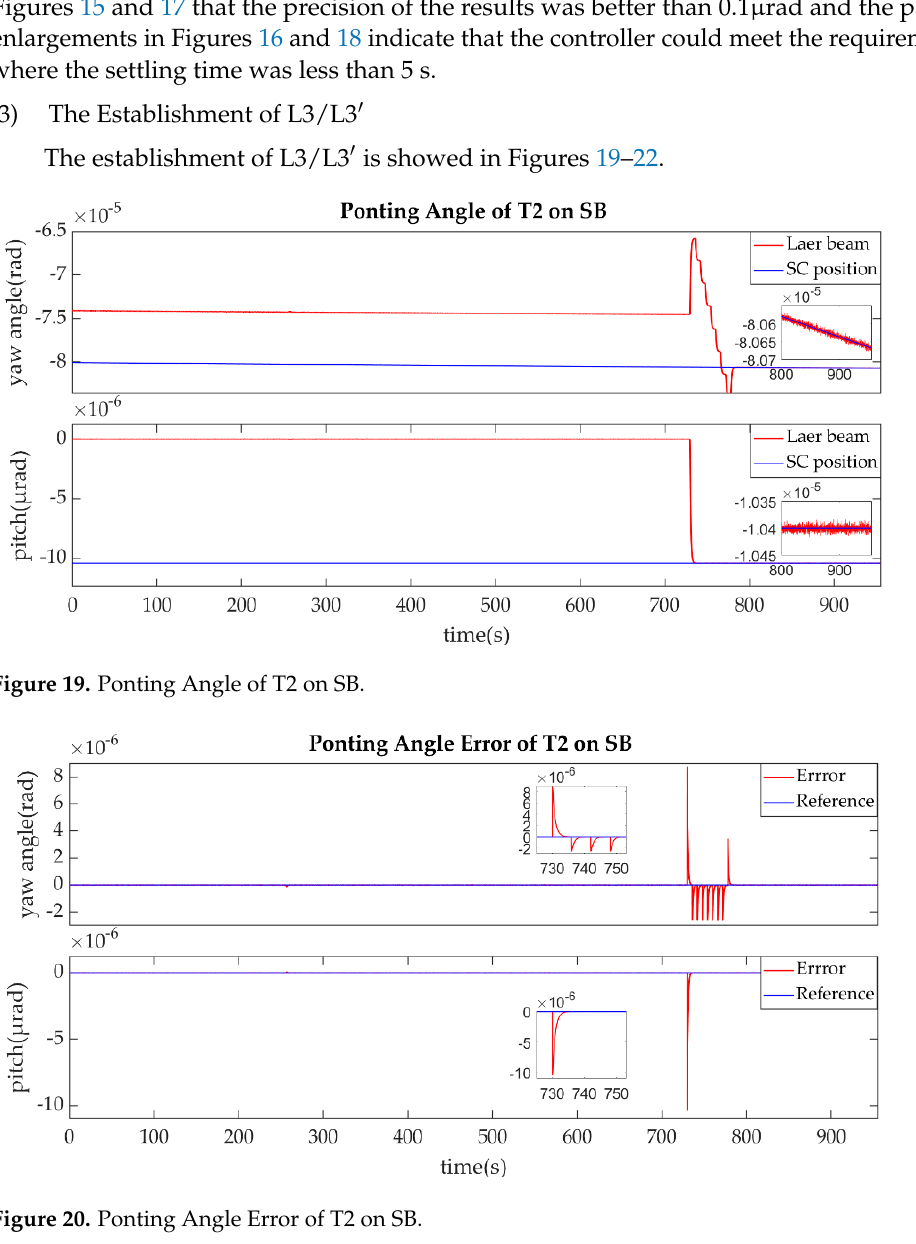
Figure 21. Ponting Angle of T1 on SC.